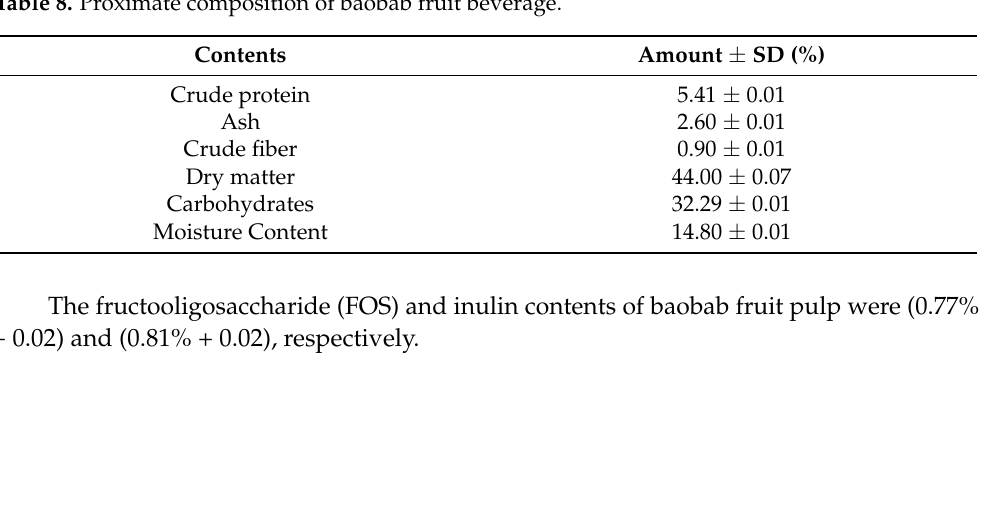
Table 8. Proximate composition of baobab fruit